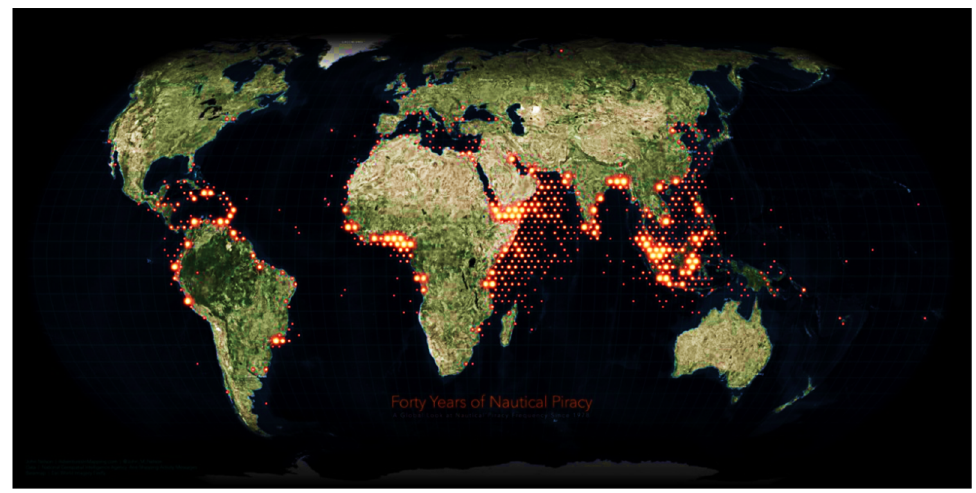
Figure 48. A map showing the distribution of marine piracy events over a forty-year period [163].